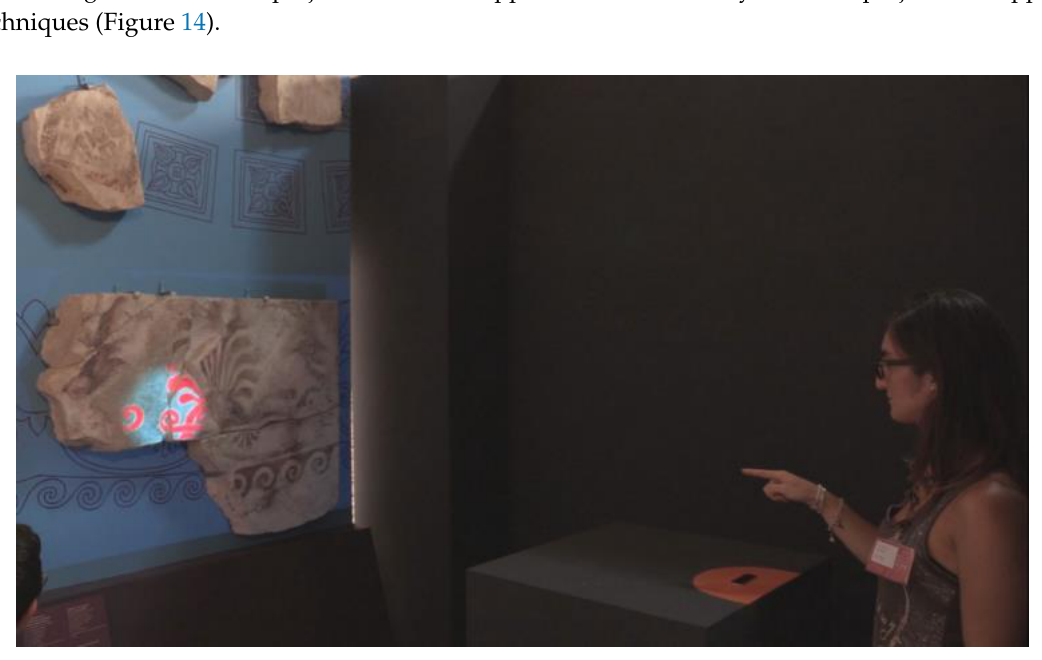
Figure 14. Revealing flashlight , Keys to Rome exhibition at Trajan Markets in 2015 The color is directly projected on the original artifacts through a virtual flashlight controlled by the (http://keys2rome.eu/). The color is directly projected on the original artifacts through a virtual user’s finger, thanks to the use of Leap Motion flashlight controlled by the user’s finger, thanks to the use of Leap Motion sensor.